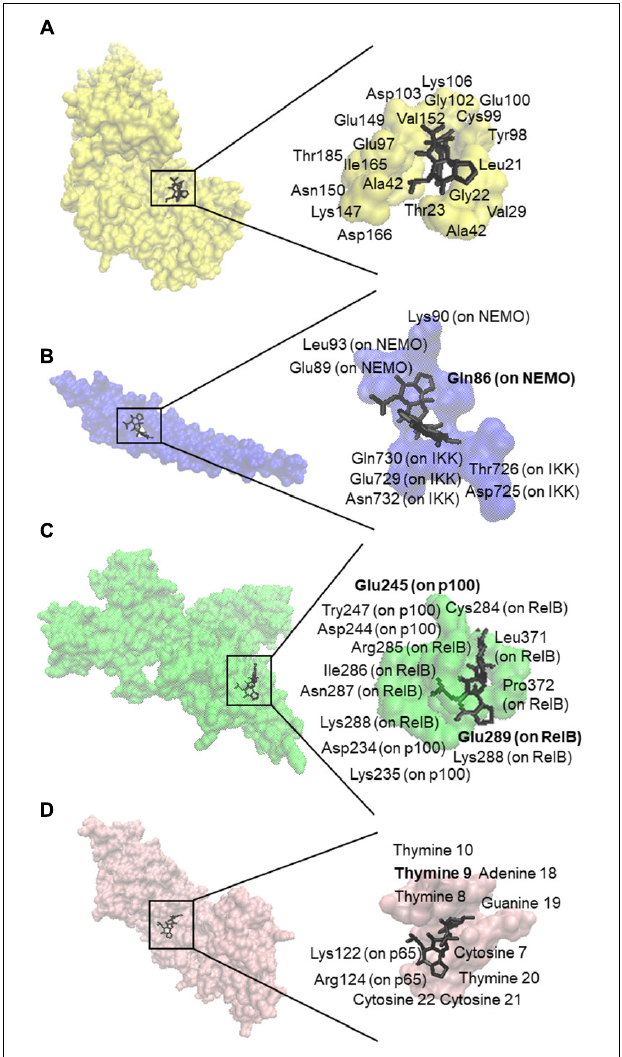
FIGURE 5 | Molecular docking studies of bromocriptine to NF- κ B pathway proteins. (A) Docking poses into the ATP binding site of IKK (PDB code: 3RZF in yellow surface representation). (B) Docking poses into the interaction site of the IKK (PDB code: 3BRT in blue surface representation). (C) Docking poses into the DNA binding site of NF- κ B (PDB code: 3DO7 in green cartoon representation). (D) Docking poses into the DNA binding site of the NF- κ B-DNA complex (PDB code: IVKX in pink cartoon representation). The residues that bound to compounds by hydrogen bond are shown in